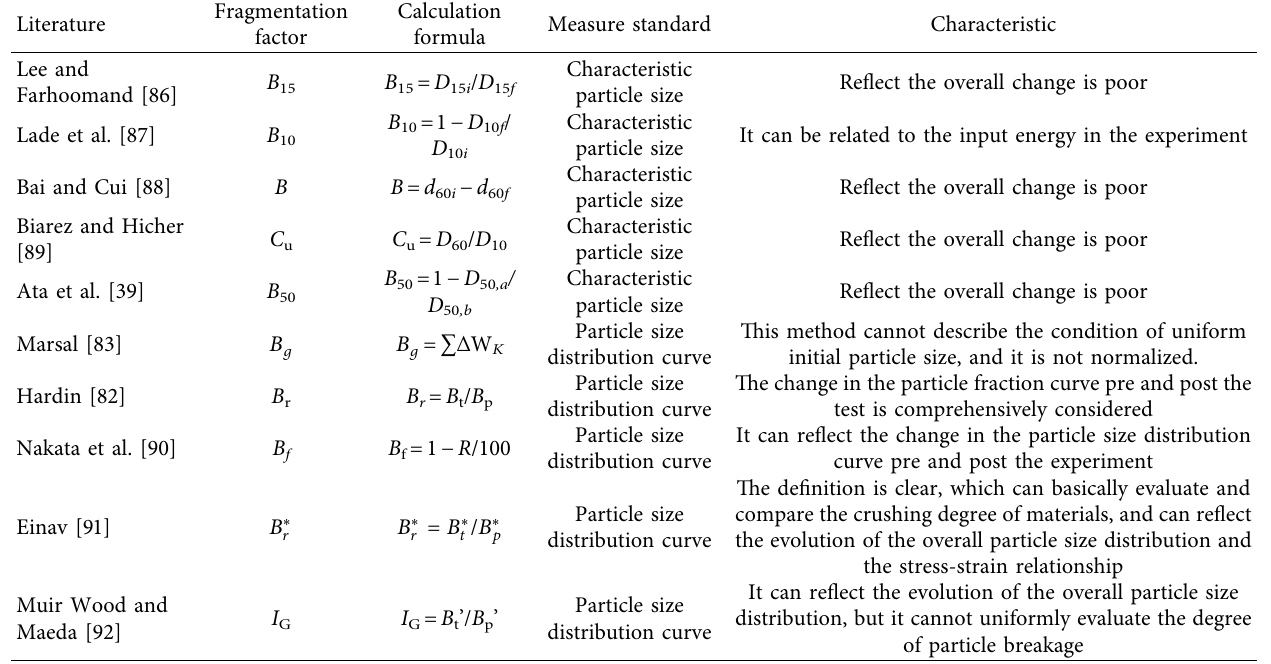
Table 3: Quantitative description models of particle